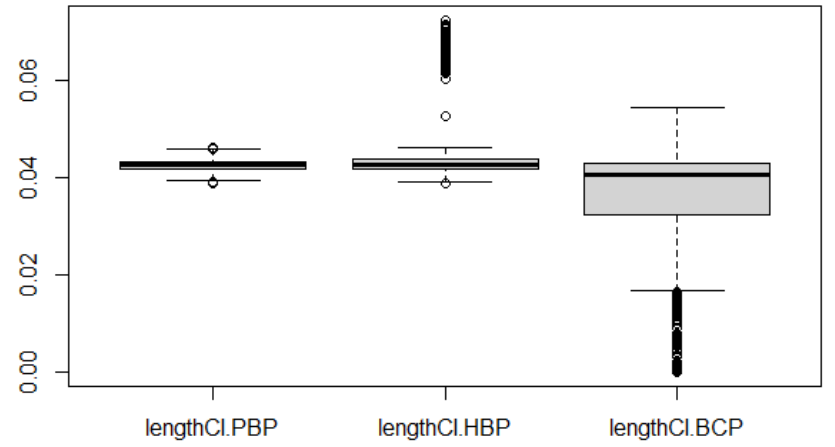
Figure 2. The box plots of bootstrap confidence intervals based on the PBP, HBP and BCP methods for the mixture GE